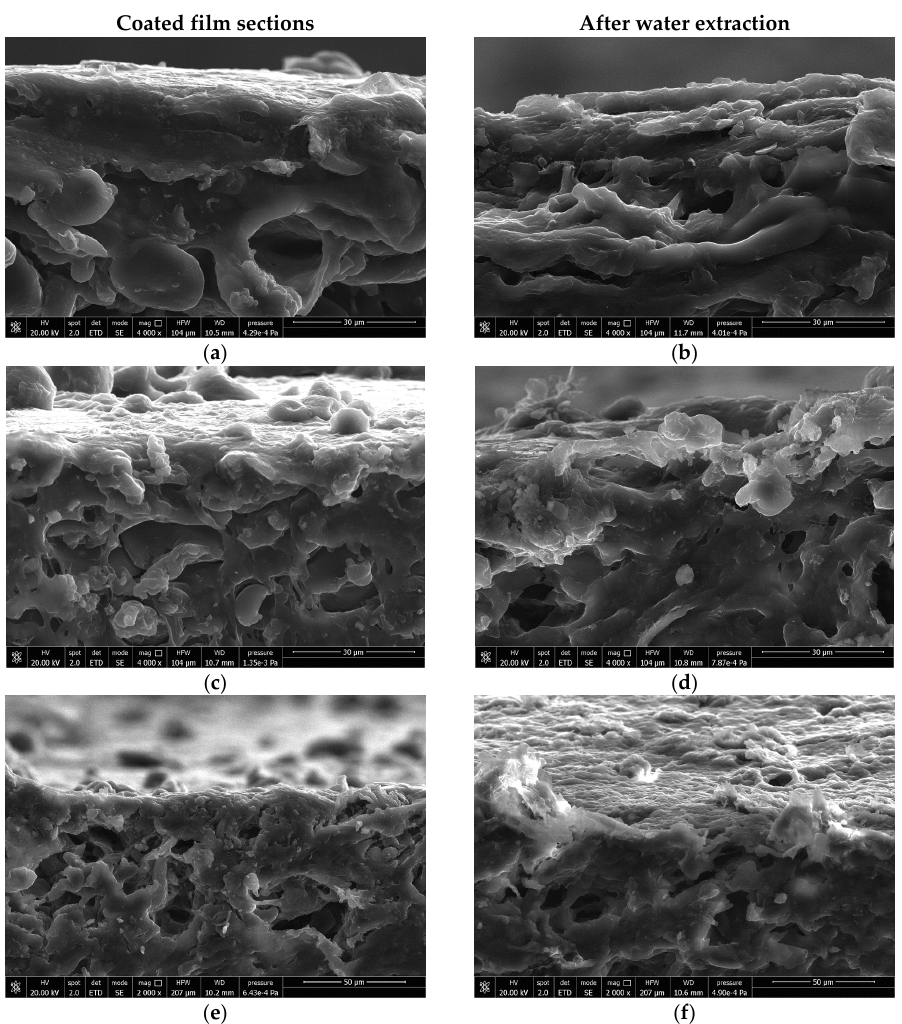
Figure 7. FESEM micrographs of the cryo-fractured films consisting of: ( a ) coated BMSMART, ( b ) coated BMSMART after water extraction, ( c ) coated EBM1, ( d ) coated EBM1 after water extraction, ( e ) coated EBM5 and ( f ) coated EBM5 after water extraction.